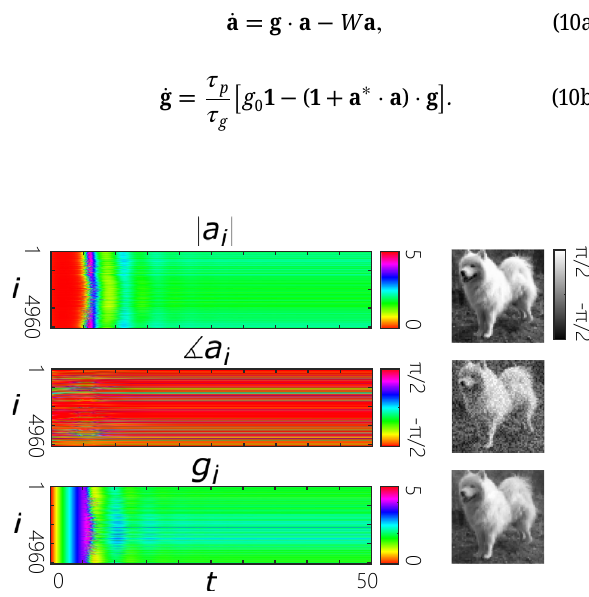
Figure 6: An exemplary simulation of the network described in Figure 4 when considering gain dynamics according to Eqs. (10). Left: A raster plot of the dynamics of the amplitudes, phases and the gains of the oscillators. Right: Reconstruction of a perturbed image. In these simulations, the photon to gain lifetime ratio is taken to be 𝜏